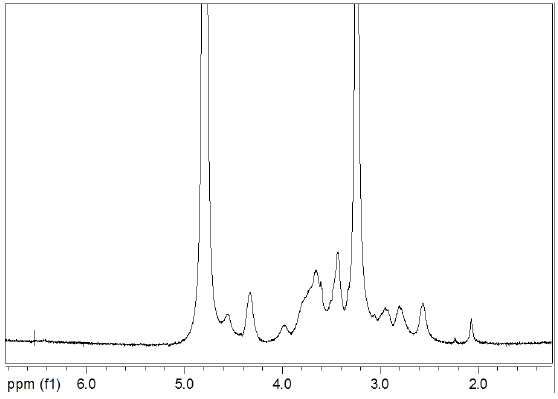
Figure 2: 1 H NMR spectrum of